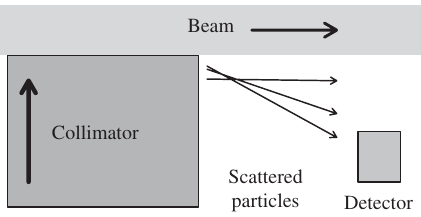
FIG. 2. Schematic of the apparatus setup. The BLM placed downstream of the collimator jaw detects local losses induced by the beam impacts following the movement of the jaw.